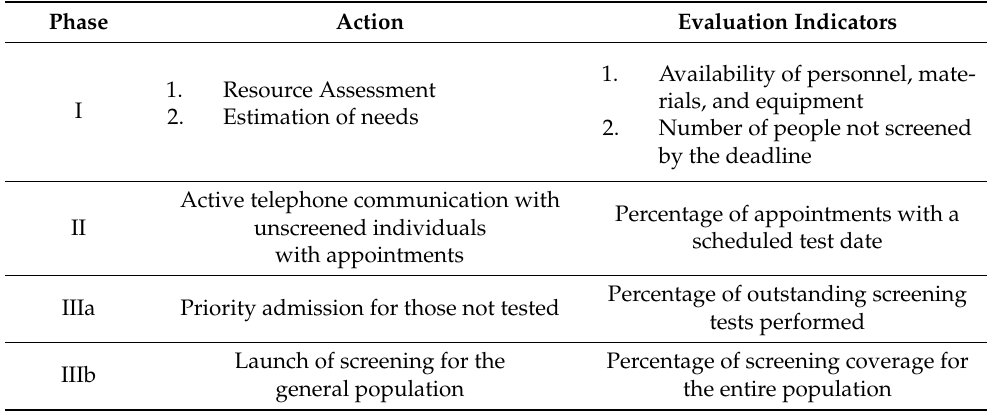
Table 10. Proposed pattern of return to cervical cancer screening after interruption due to the COVID-19